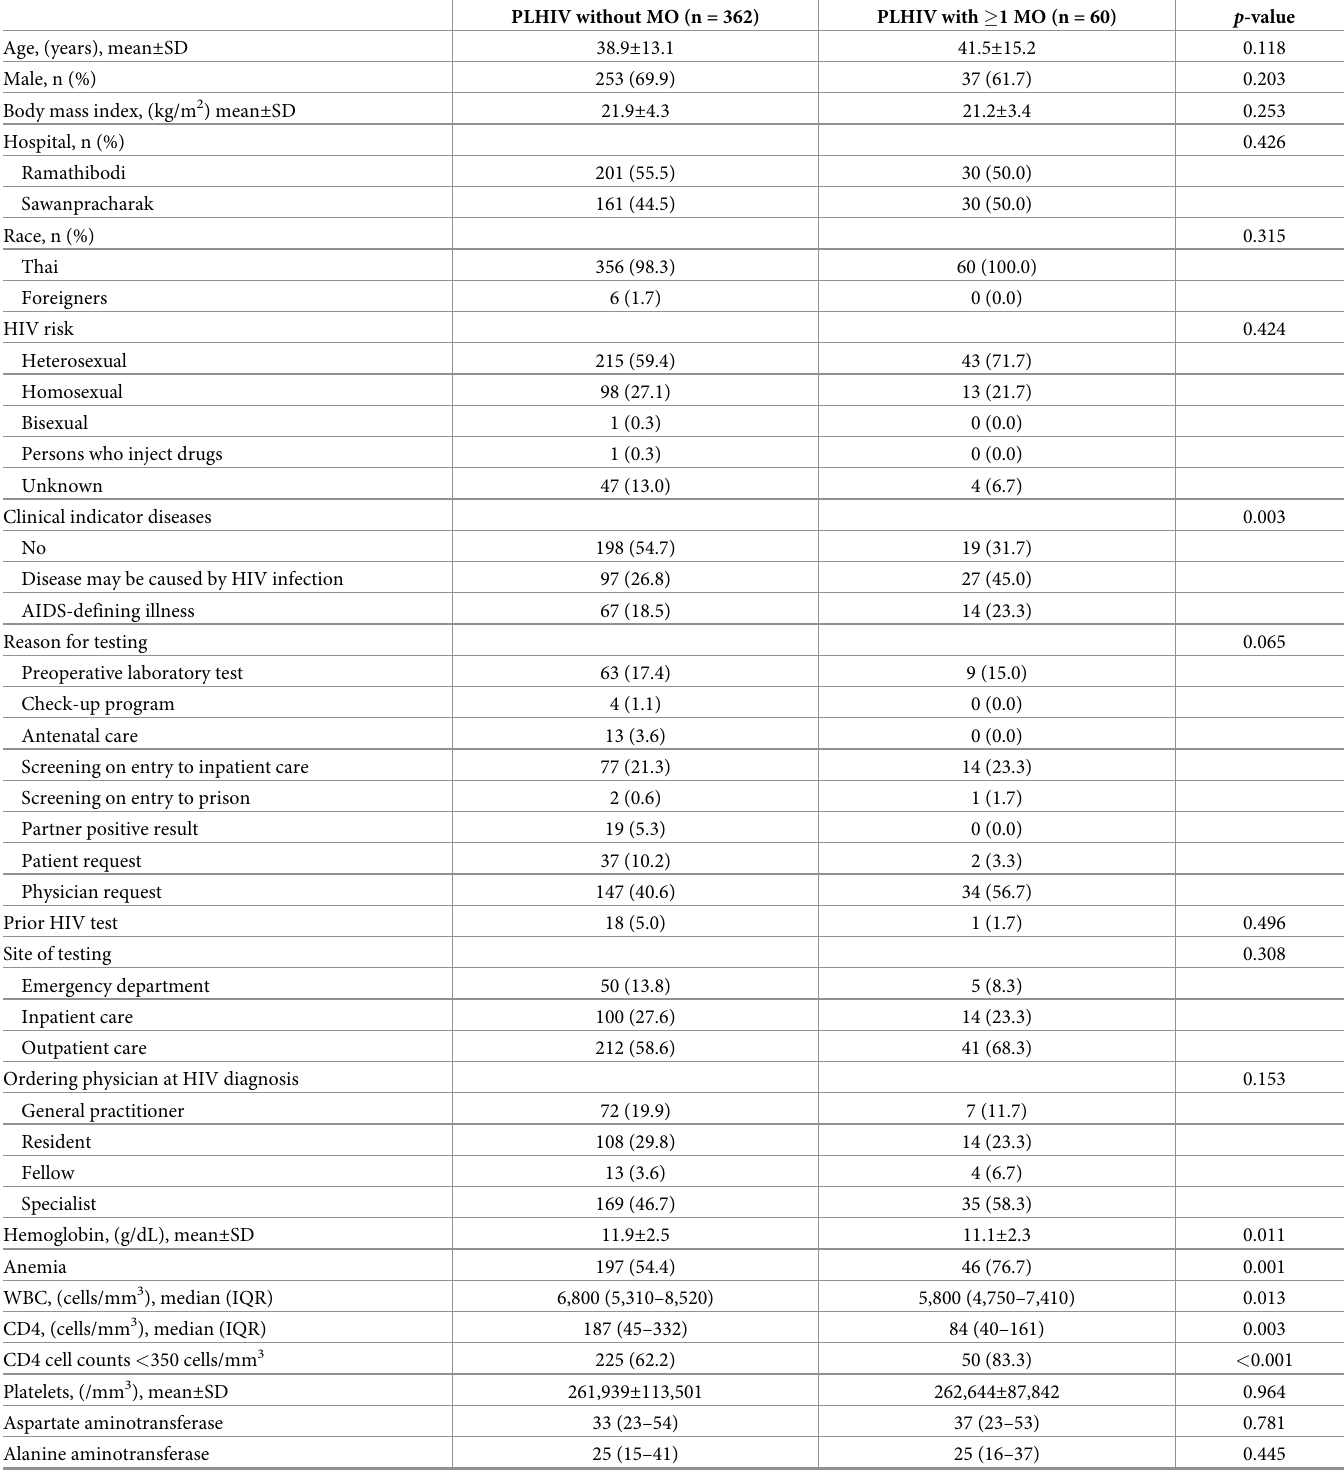
Table 1. Characteristics of newly diagnosed PLHIV at HIV diagnosis categorized by a history of missed opportunities for earlier HIV